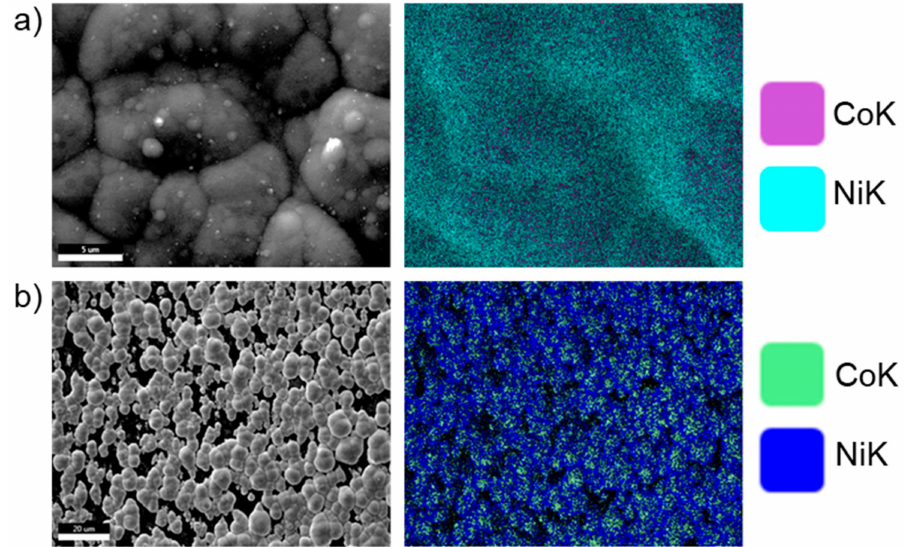
Figure 7. SEM image ( left ) and elemental mapping ( right ) of the Co-Ni films obtained at − 1.0 V for 15 min: ( a ) on film and ( b ) overgrown